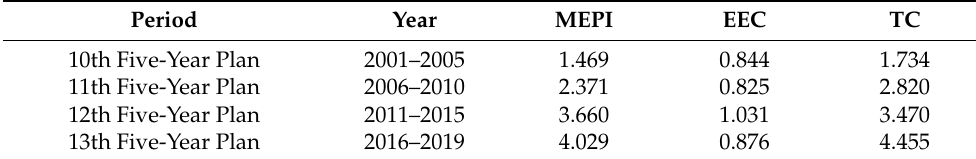
Table 3. Accumulated energy efficiency and its determinants during each Five-Year Plan.